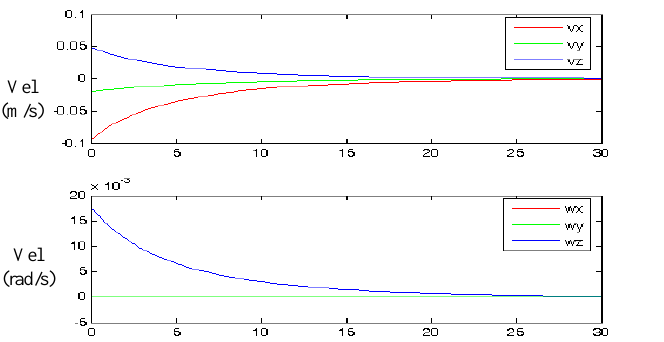
Figure 10. Velocities during the visual servoing task. Experiment